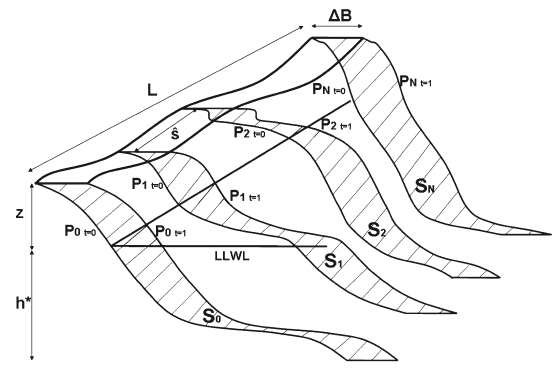
, P , P , P , 0 1 2 3 , S , S , S , … , S . Lowest low water 0 1 2 3 N are also